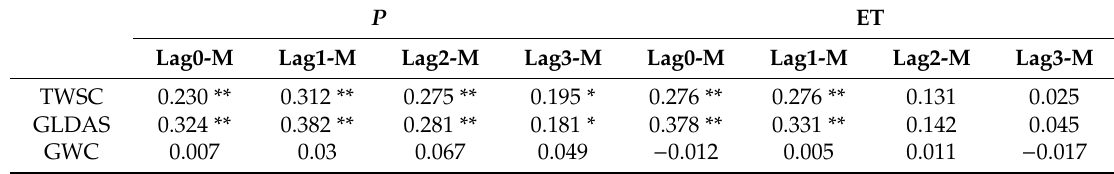
Table 3. Correlation between hydrological factors at monthly scale in a di ff erent lag period.